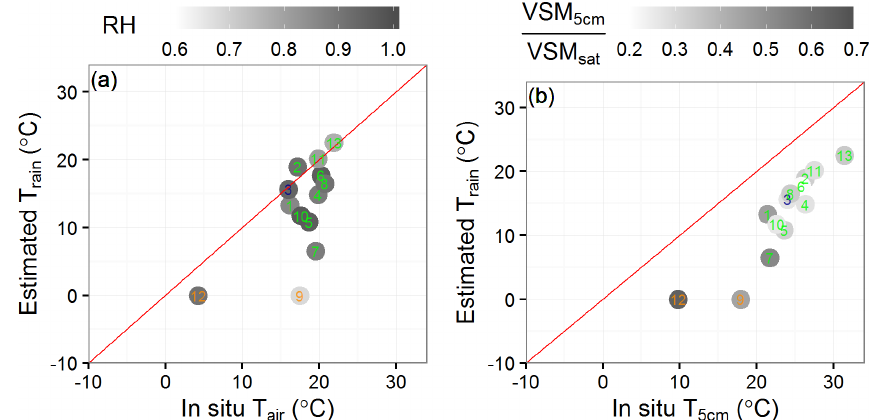
Figure 8. Estimated T rain for the 13 cases listed in Table 5 vs. observed ambient T air (a) and observed T 5cm (b) , with levels of grey indicating air relative humidity (RH, dimensionless) and VSM 5cm to VSM sat ratio (dimensionless) values at time t 1